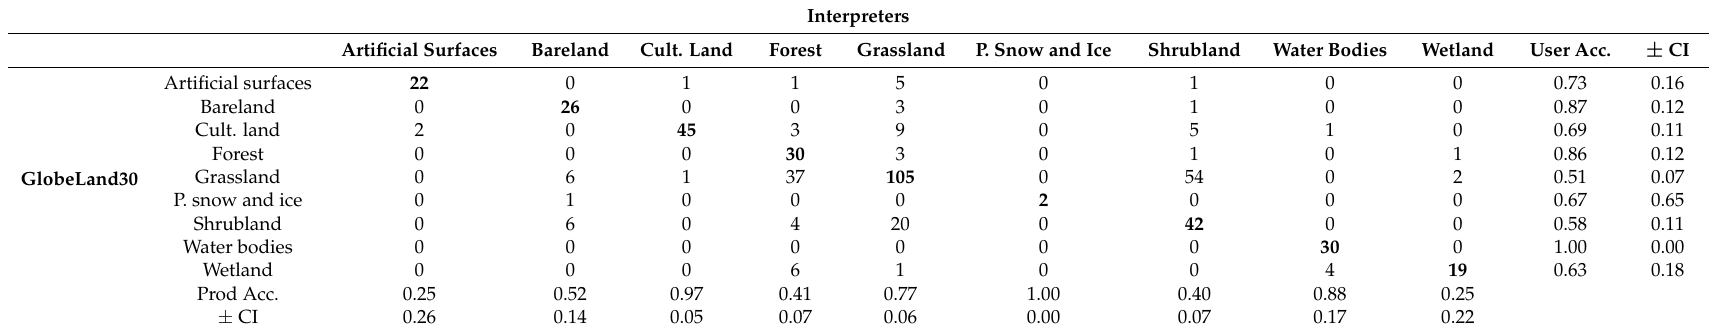
Table 7. Confusion matrix for Sample 2 ( n = 500) that allow for multiple classes when Landsat or other similar resolution imagery is only available for validation.